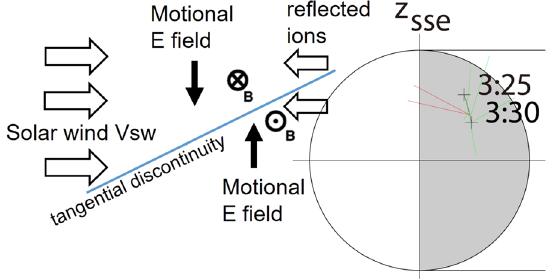
Fig. 9 A schematic illustration of hot flow anomaly formation on August 5, 2008. The motional electric fields induced by the reflected ions point toward the tangential discontinuity on both sides of the discontinuity